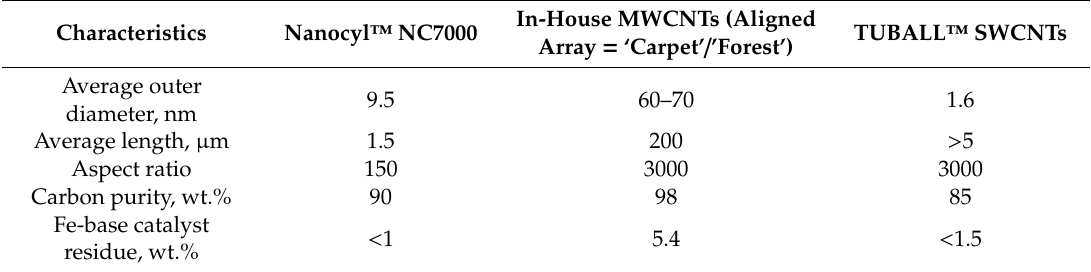
Table 1. Characteristics of CNTs used in this